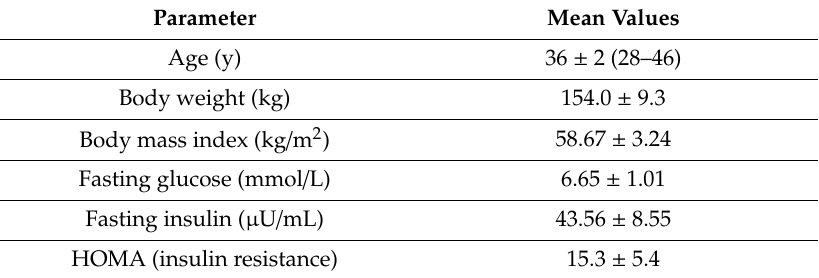
Table 1. Clinical parameters of the group of twelve severely obese